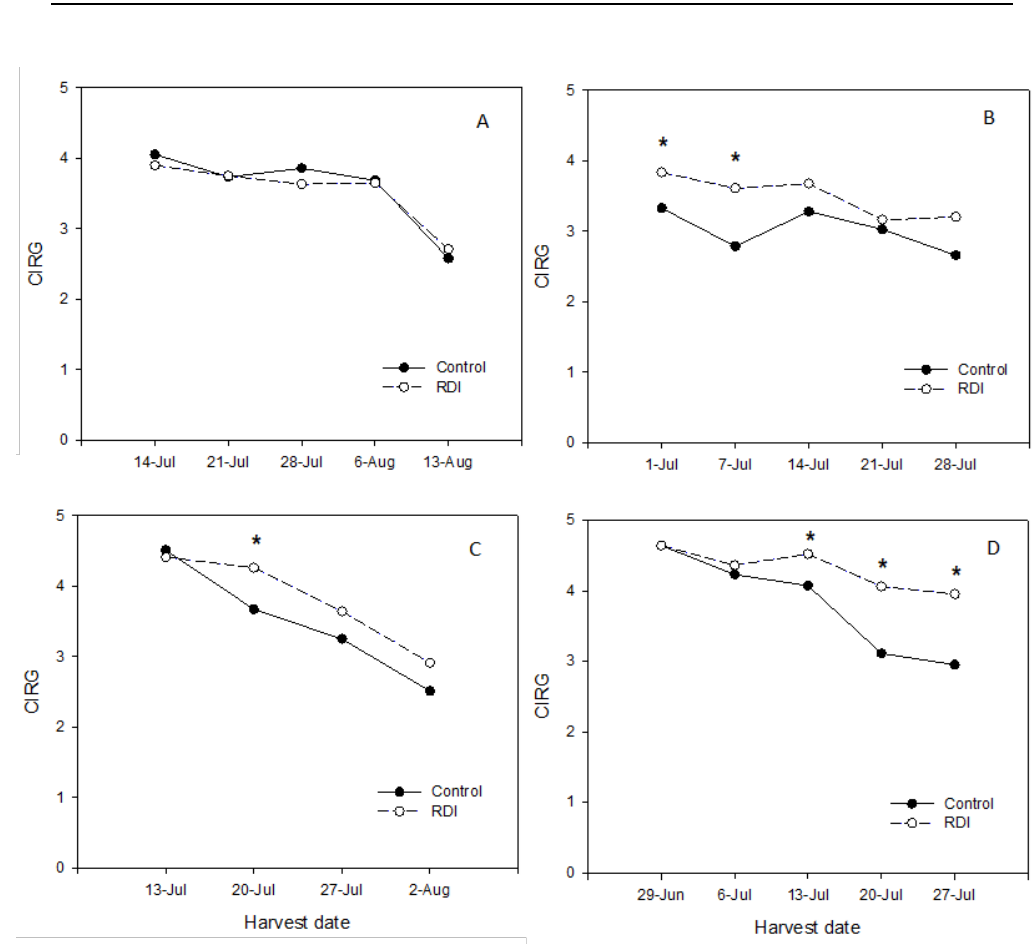
Figure 6. Evolution of the red grape color index (CIRG) throughout the harvest season in plants cultivated under net ( A and C ) and under a plastic greenhouse ( B and D ) in 2015 ( top ) and 2016 ( bottom ). When * is present, it indicates significant di ff erences between irrigation treatments (Student’s T test, p < 0.05).